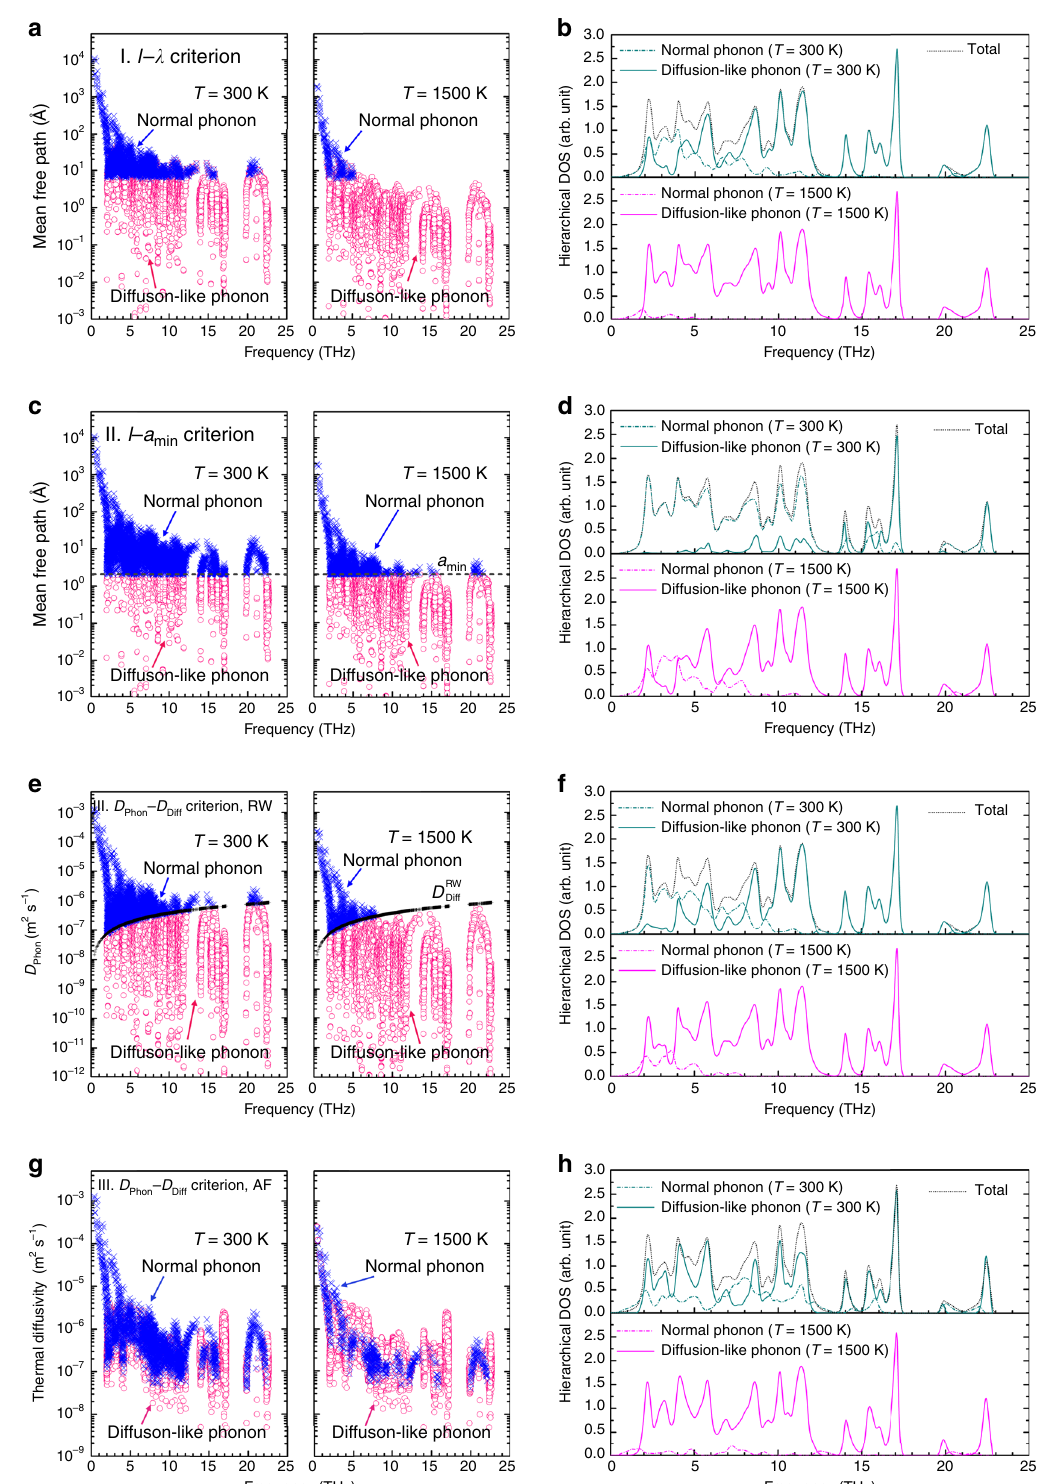
Fig. 1 Hierarchy of lattice vibrations in La 2 Zr 2 O 7 . The vibrational modes are assigned as normal phonons or diffuson-like phonons according to a Criterion I, whether their mean free path ( l ) is above or below the vibrational wavelength ( λ ); c Criterion II, whether their l is above or below the minimum interatomic spacing ( a min = 2.1 Å for La 2 Zr 2 O 7 , drawn in dashed line); e Criterion III, whether the phonon thermal diffusivity ( D Phon ) is above or below the diffuson thermal diffusivity ( D Diff ), in which D Diff is calculated based on the random-walk theory ( D RW frequency in black marks; and g Criterion III, with D Diff calculated based on the Allen – Feldman formula ( D AF each vibrational mode is plotted. The calculated hierarchical phonon density of states (DOS) for normal phonons and diffuson-like phonons according to b Criterion I; d Criterion II; f Criterion III coupled with the random-walk (RW) theory; and h Criterion III coupled with the Allen – Feldman (AF) theory. Note: the ordinary frequency ( ν = ω /2 π ) in units of THz is used for illustration. Source data are provided as a Source data fi